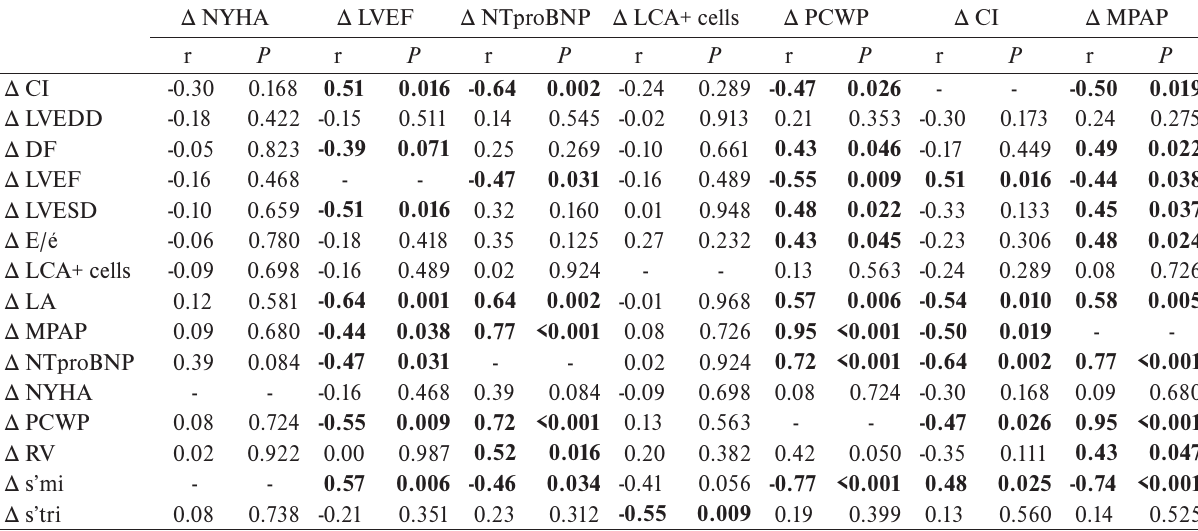
Table 4. Corelations parameters changes in I- group